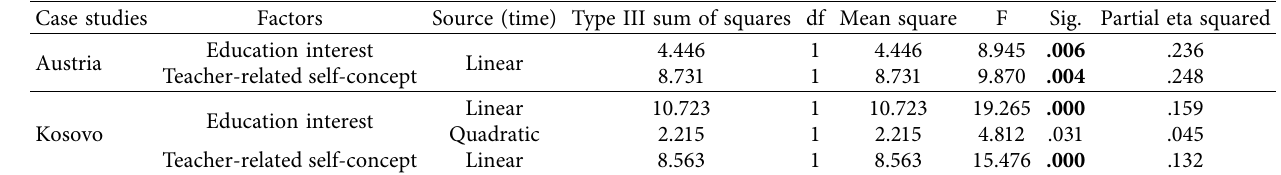
Table 8: Tests of within-subject